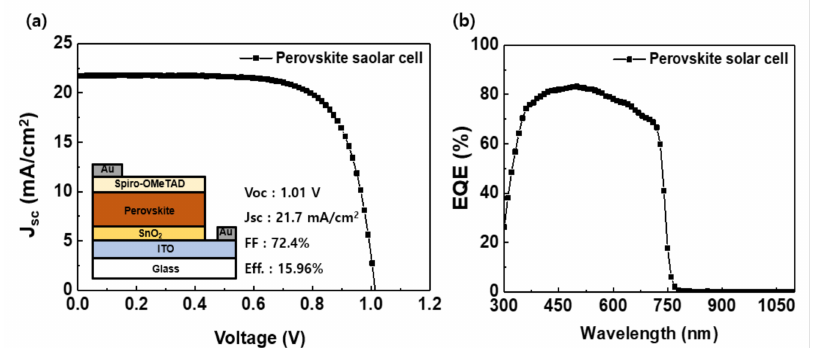
Figure 4. ( a ) J-V curve and ( b ) EQE data of the PSC on ITO patterned glass.